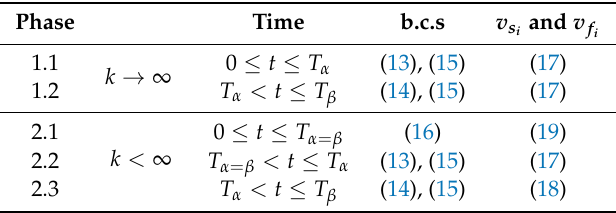
Table 2. Relevant boundary conditions for each of the Mg corrosion phases for the two cases k → ∞ and k < ∞